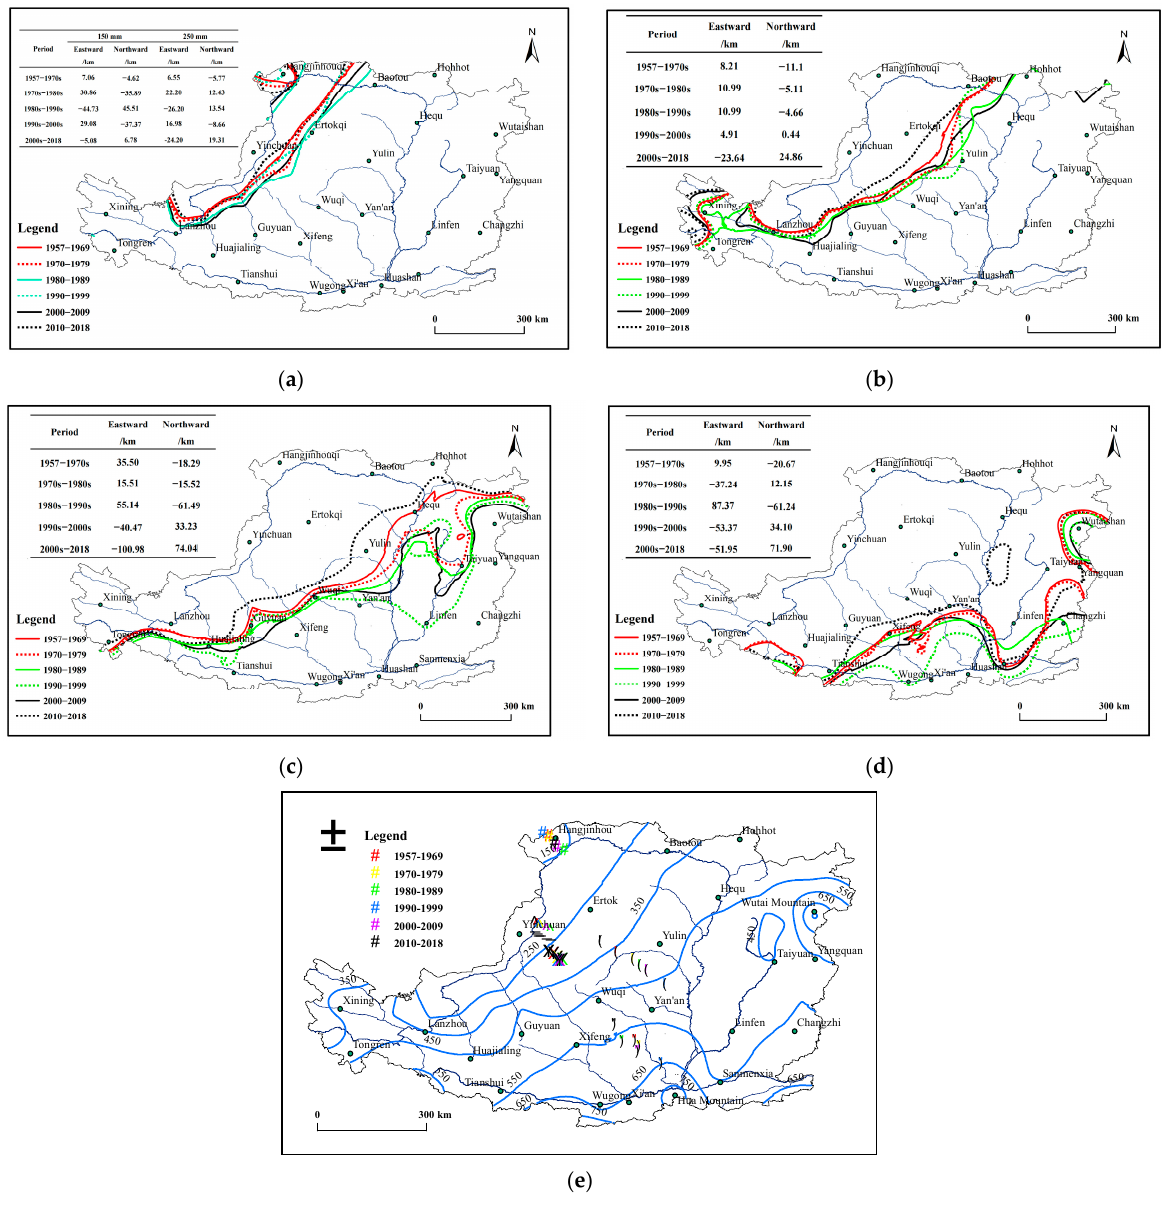
Figure 4. Isohyets and centroids at decade-scale between 1957 and 2018 over the Loess Plateau, China. The centroids of isohyets of the 150, 250, 350, 450 and 550 mm are expressed by the triangle, star, diamond, circle and square, respectively. ( a ) The 150 and 250 mm isohyets and shift distance; ( b ) the 350 mm isohyet and shift distance; ( c ) the 450 mm isohyets and shift distance; ( d ) the 550-mm isohyets and shift distance; ( e ) the isohyets of mean annual precipitation and locations of the centroids of